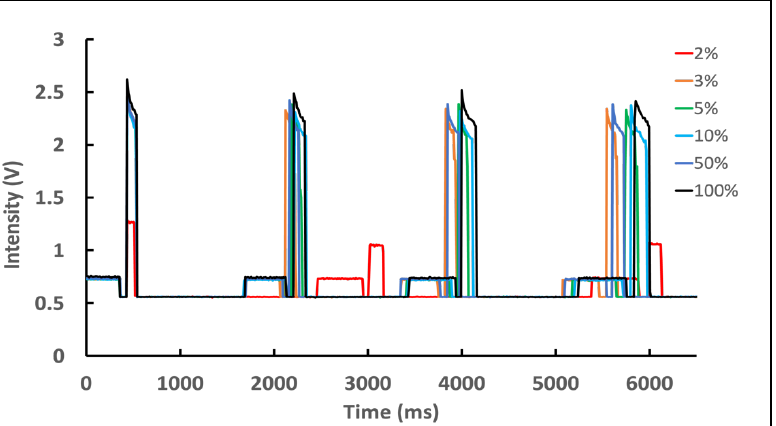
Figure 4. Elongated recovery time with iPhone 6s at extreme low state of charge. 437 nm flash intensity at 2% (red) was significantly reduced and the phone took a long time to recover for subsequent flash activation. The smartphone was rested at the start of each measurement series.